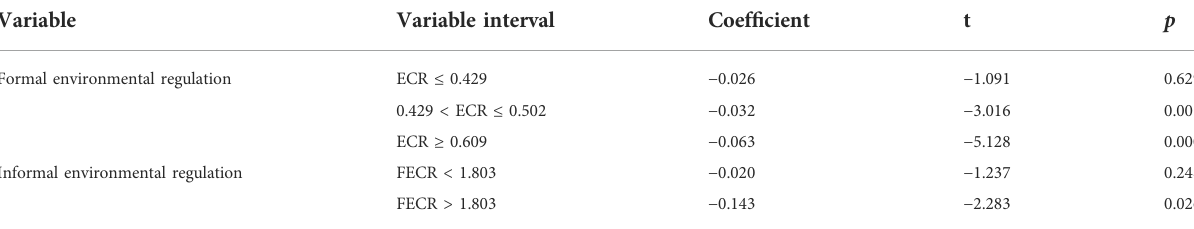
TABLE 7 Estimation results of the threshold model. Variable Variable interval